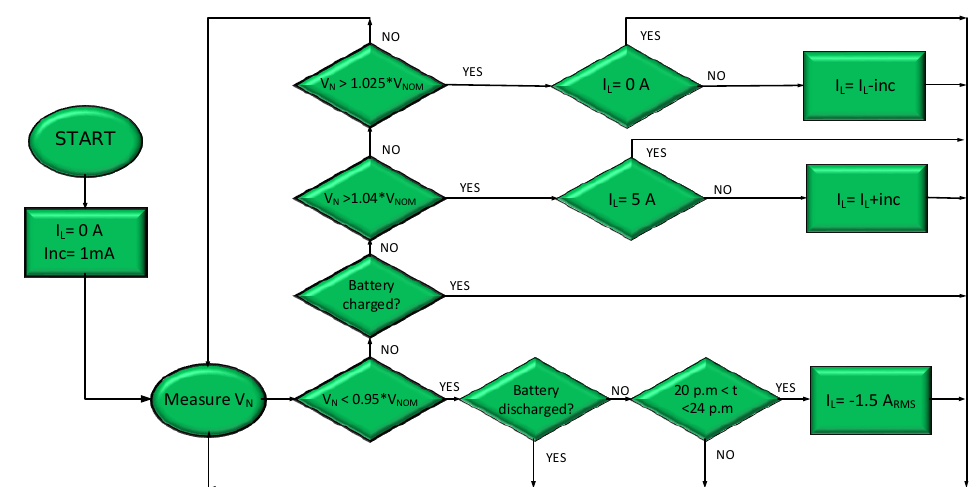
Figure 8. Flow diagram.